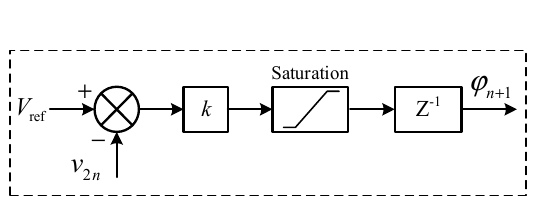
Figure 3. Block diagram of the one-step delay digital controller.